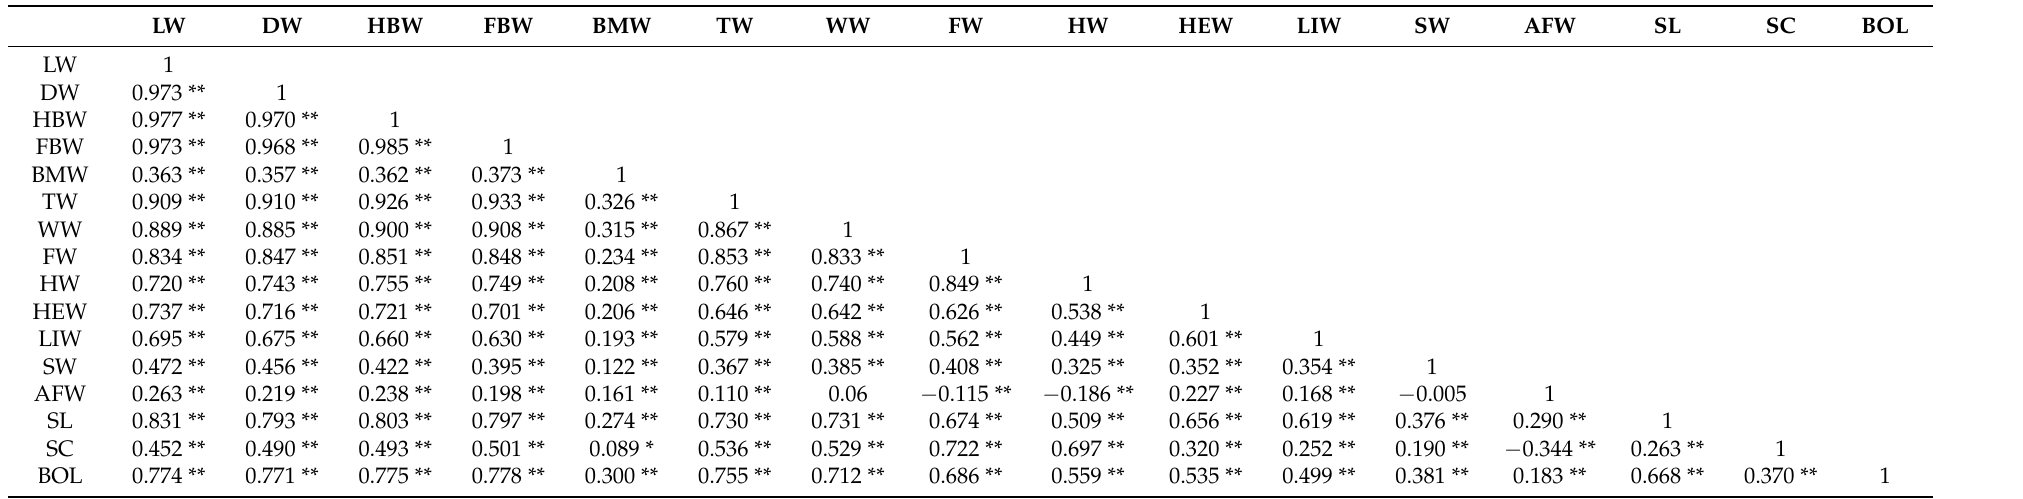
Table 3. Correlation coefficients (r) between carcass